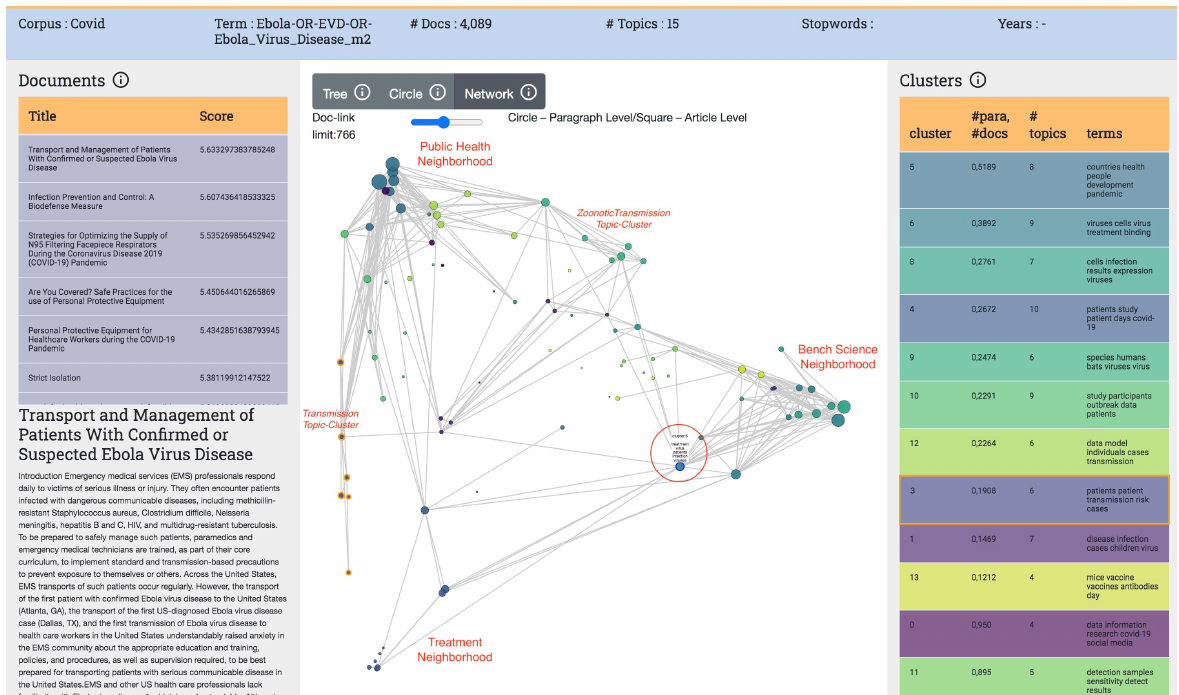
Figure 11. Network visualization of the Ebola Topic